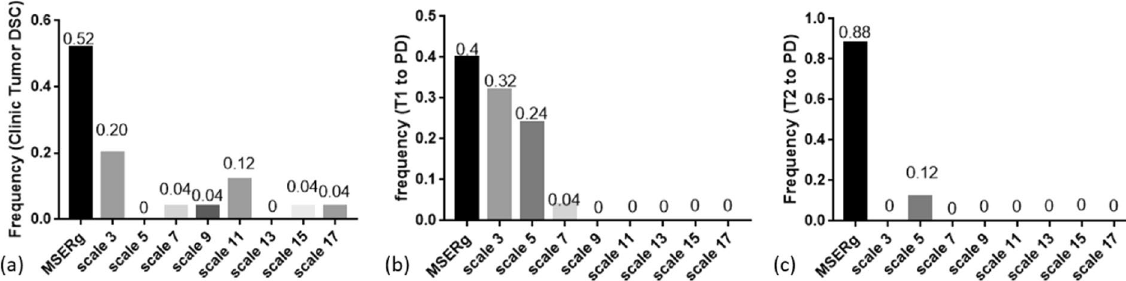
Figure 7. Illustration of a frequency plot showing in how many instances either SSERg or MSERg registration yielded the best registration result. We compared 8 different SSERg combinations along with MSERg on the same 25 clinical and synthetic testing cases. ( a ) Shows the frequency of each registration method having the greatest Tumor DSC within the clinical testing set. ( b ) and ( c ) illustrate the frequency of each registration method with the least mean deformation difference (MDD), in case of T1 to PD and T2 to PD registration respectively. Compared to SSERg, MSERg has more accurate and robust registration performance across different